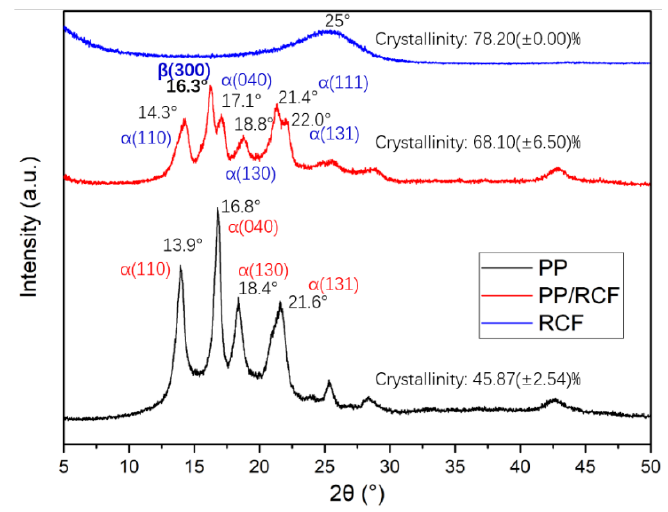
Figure 15. X-ray di ff raction (XRD) patterns of PP, RCF and PP / Figure 15. X-ray diffraction (XRD) patterns of PP, RCF and PP/RCF. Figure 15. X-ray diffraction (XRD) patterns of PP, RCF and PP/RCF.